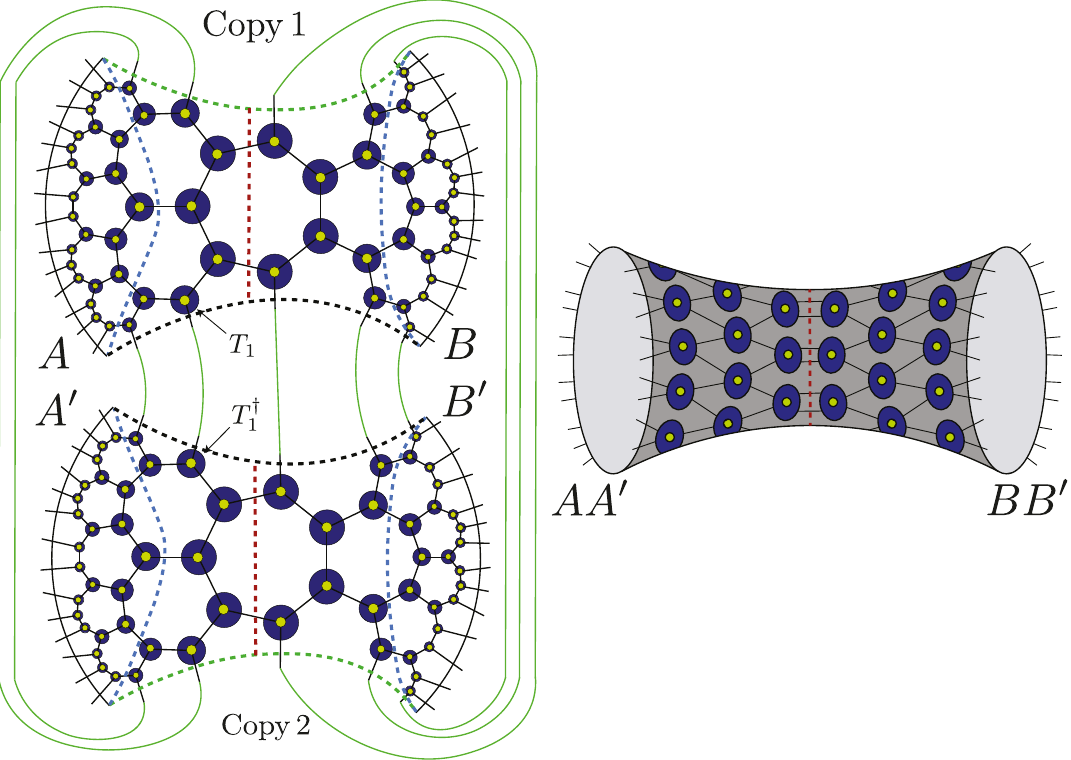
Figure 4 . (Left): A reduced tensor network corresponding to the entanglement wedge of AB is obtained by using the isometry from the boundary legs of subregion C to the legs at the RT surface (denoted black and green dotted lines). Two copies of this RSTN glued as shown prepare the canonically puri(cid:12)ed state. We call this doubled network TN’. (Right): Geometrically, this resembles the AdS/CFT construction discussed in [10, 17, 24]. If the RT formula holds, then S R ( A : B ) = 2 EW ( A : B